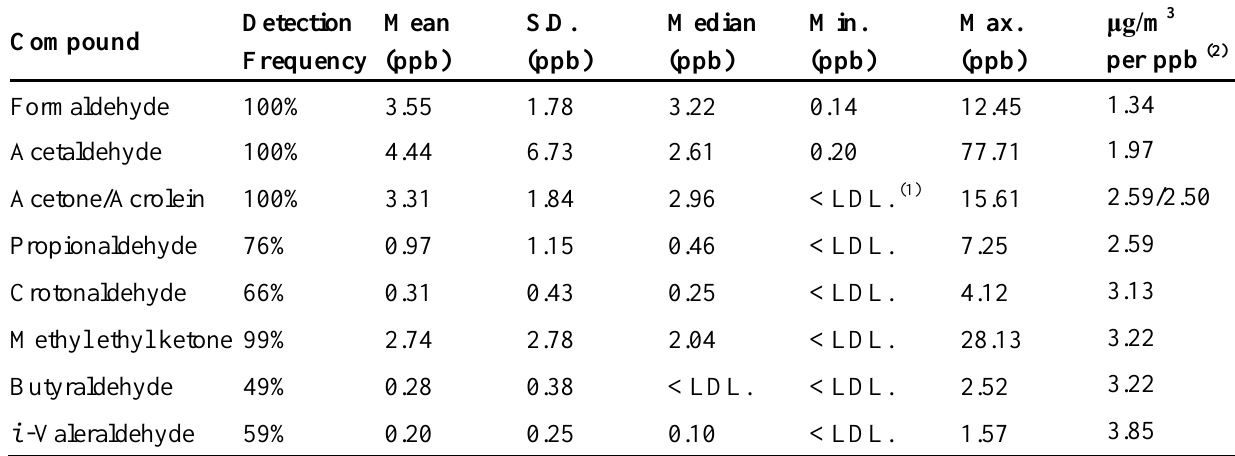
Table 3. Statistical summaries of carbonyl compounds along with detection frequencies (n =